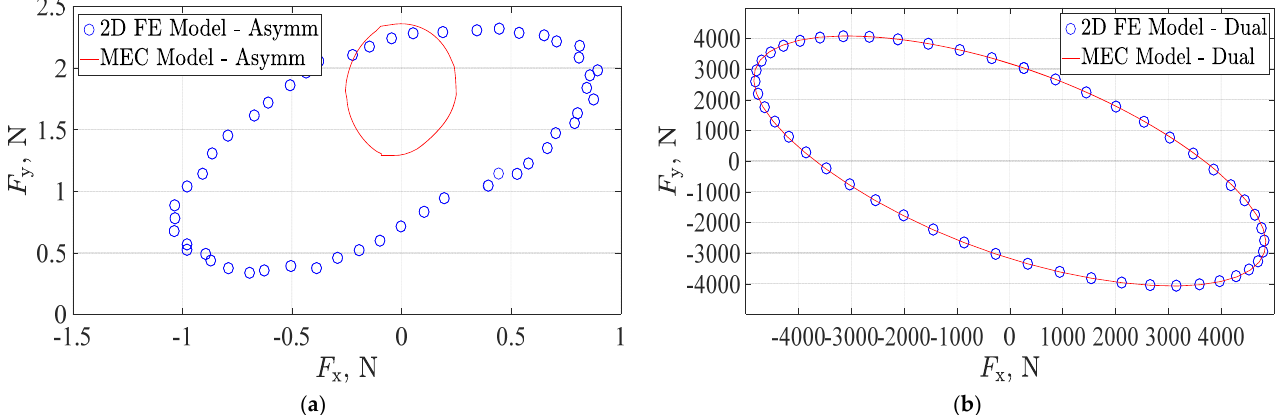
Figure 17. x ‐ y electromagnetic forces on the rotor in the charging mode. ( a ) Asymmetrical winding layout and ( b ) dual